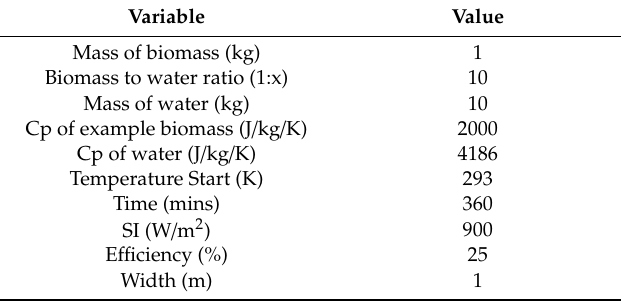
Table 2. Constant variables for the energy demand example